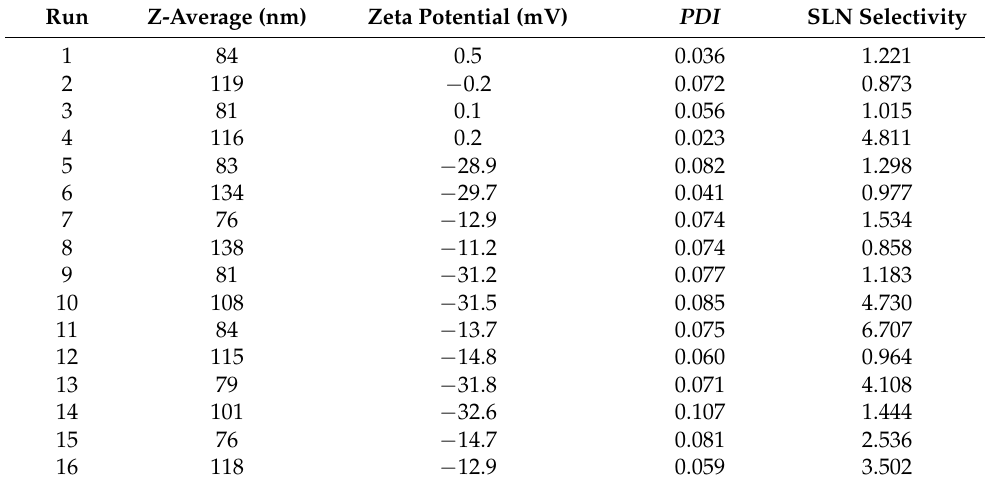
Table 2. Physicochemical properties and SLN selectivity of